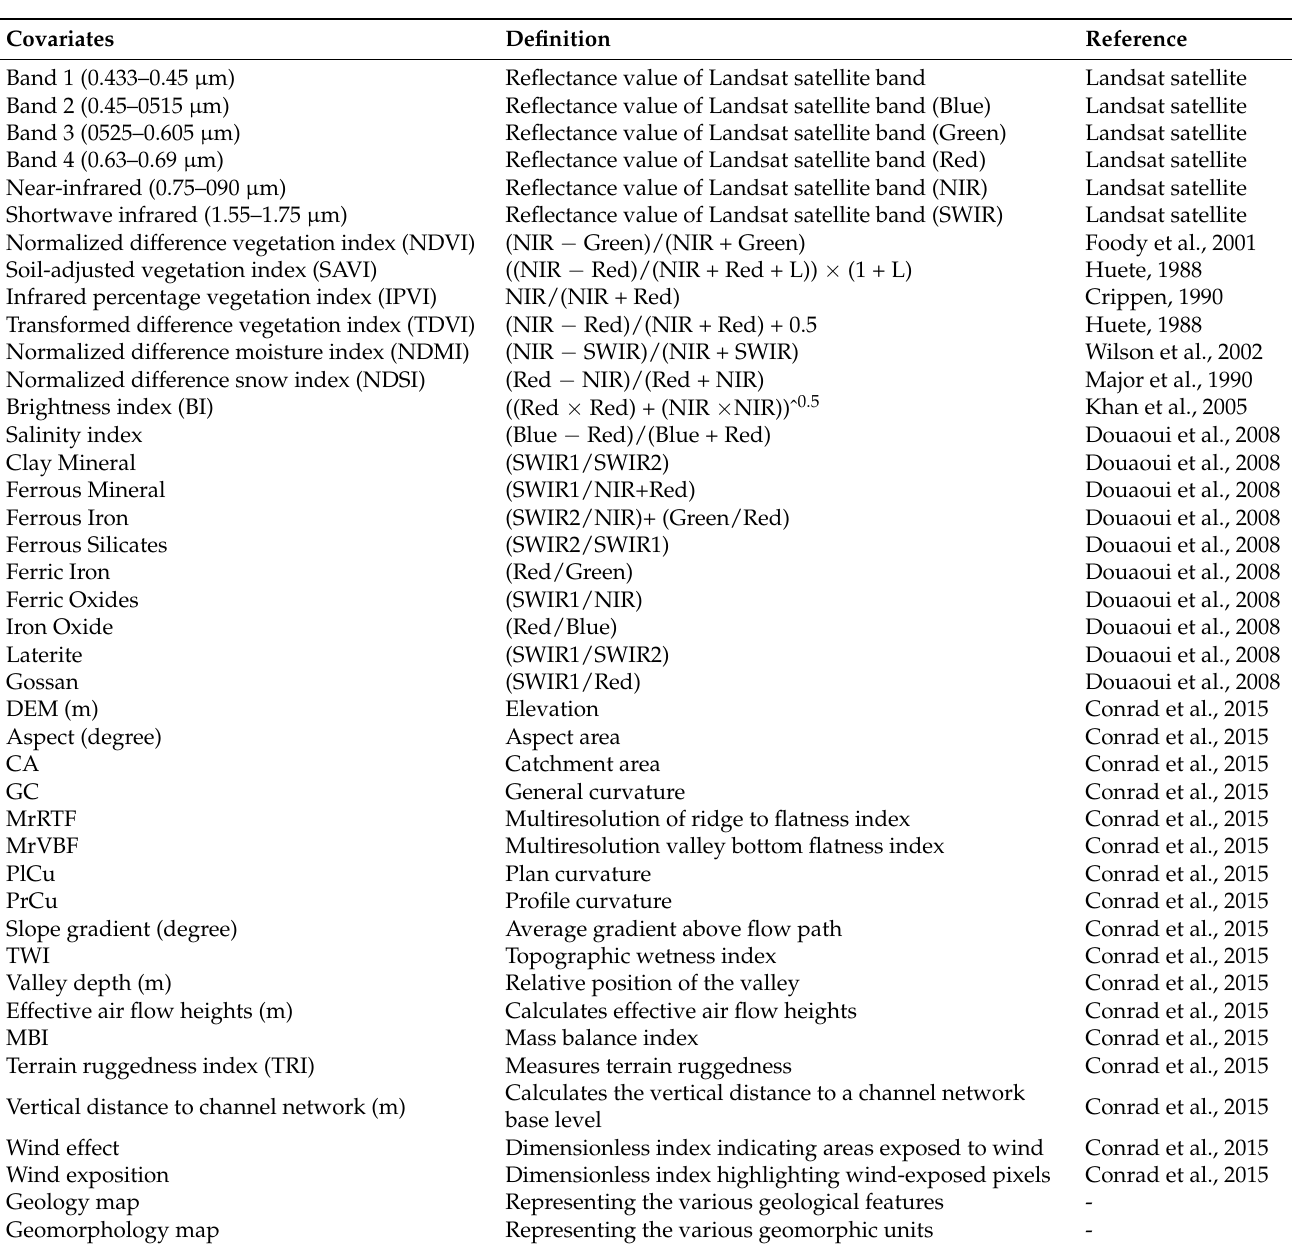
Table 1. A list of environmental covariates used to predict CEC in the study area (Resolution = 30